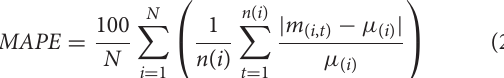
and F1-score) were determined for classifying unilateral HS vs.